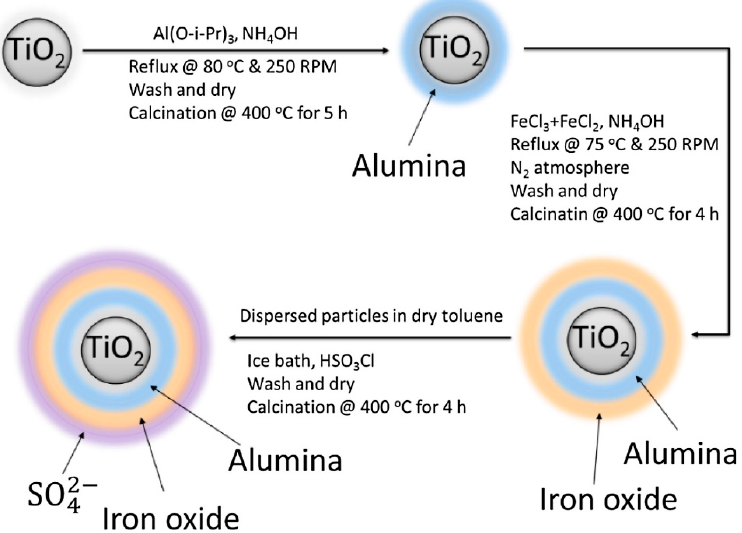
Figure 9. Paramagnetic SO 4 /Fe-Al-TiO 2 synthesis [54].